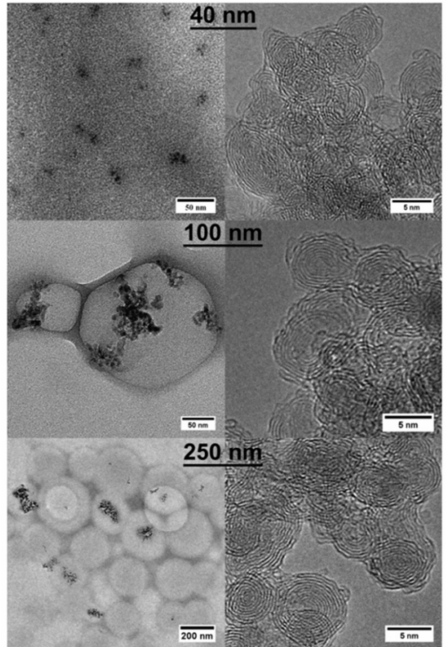
Figure 1. Transmission electron microscopy (TEM) images of onion-like carbon (OLC) aggregates, deposited on a carbon lacey TEM grid, having 3 different average sizes: 40 nm (top), 100 nm (middle) and 250 nm (bottom line). Left and right columns correspond to low and high magnification images,